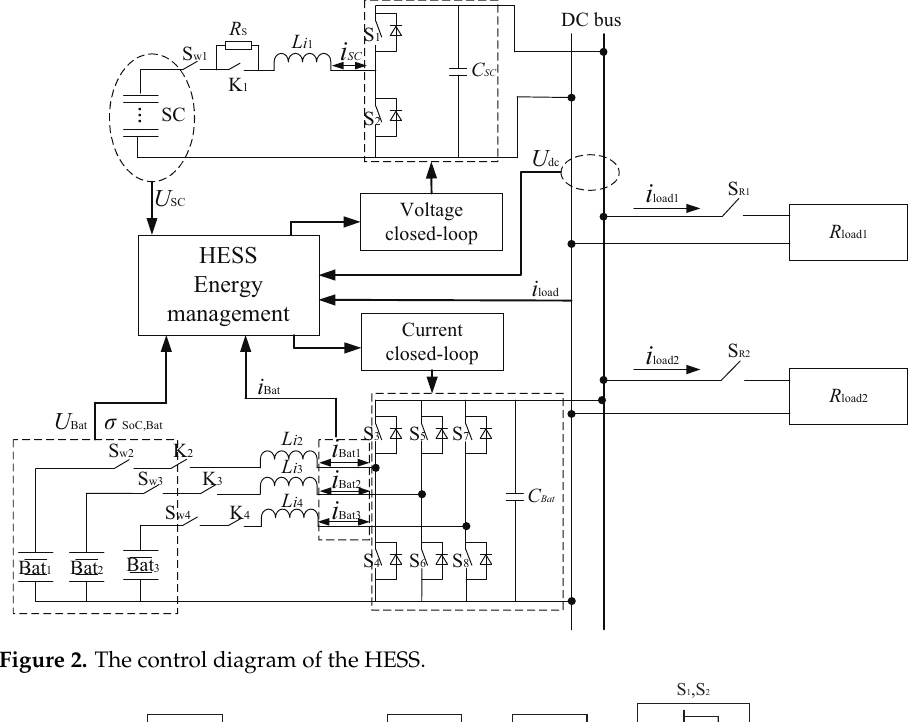
Figure 2. The control diagram of the HESS.